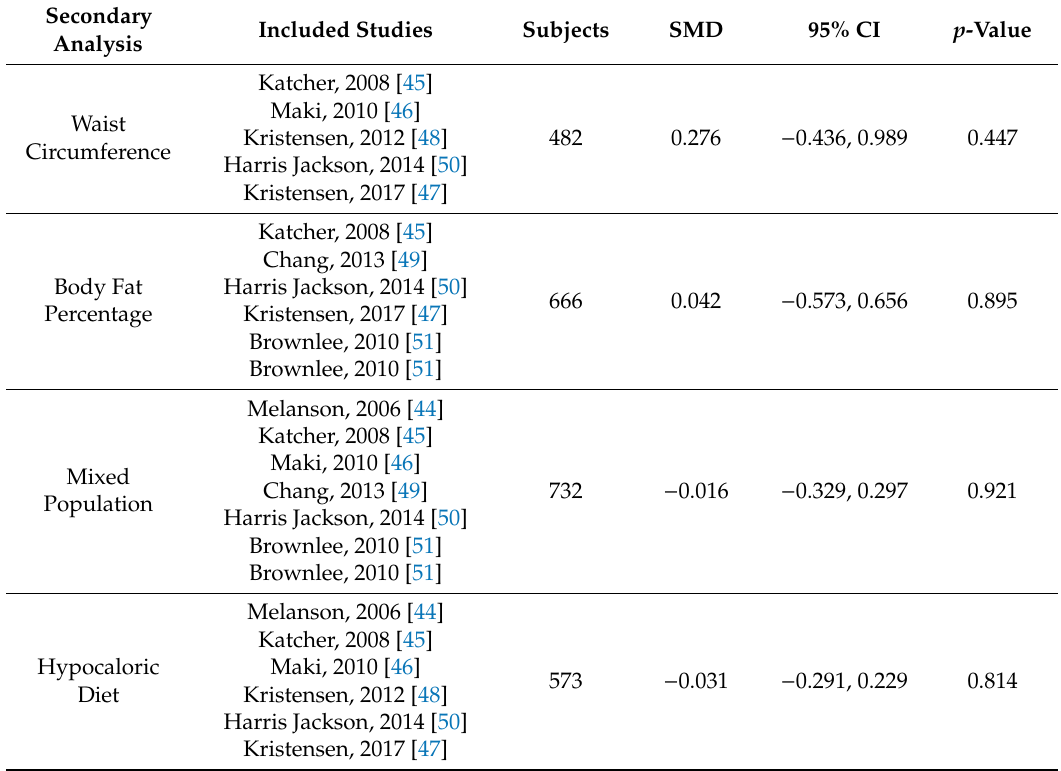
Table 3. Secondary meta-analyses of RCTs assessing the outcome of WG intake (g / day) on waist circumference, body fat percentage, or weight change (kg) 1,2